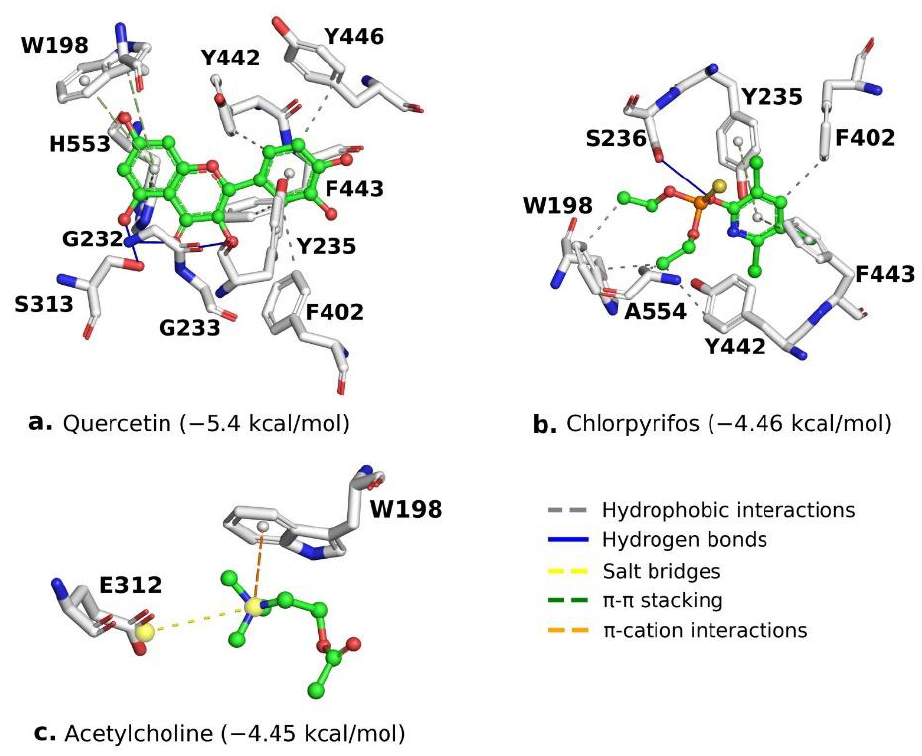
Figure 4. Interaction profile of the compounds in the modeled AChE protein. ( a ) Quercetin, ( b ) chlorpyrifos, and ( c ) acetylcholine.